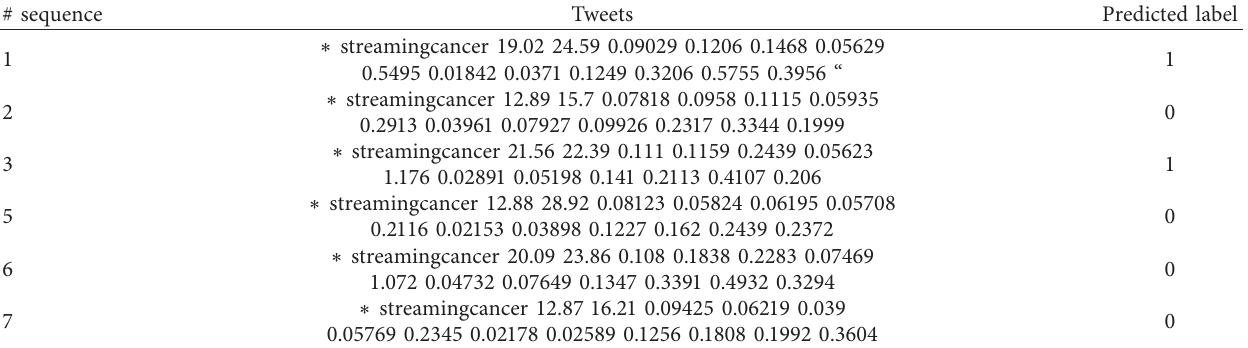
Table 6: A sample of structure tweets and the predicted